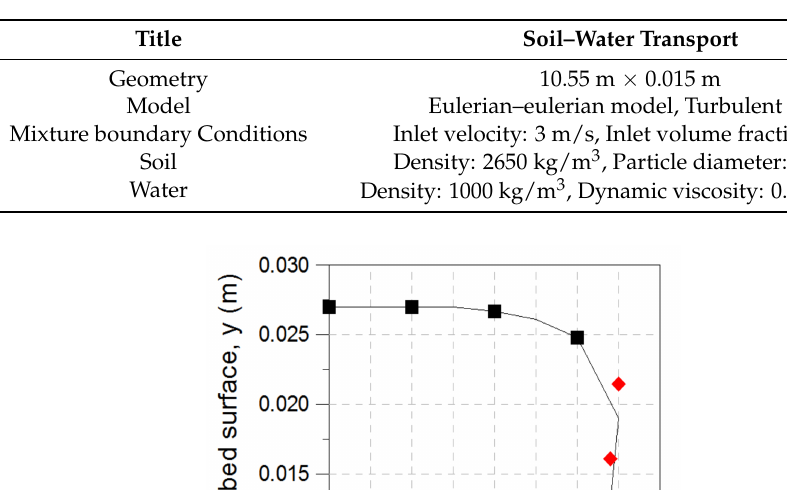
Table 3. Simulation conditions for comparison with experimental results.